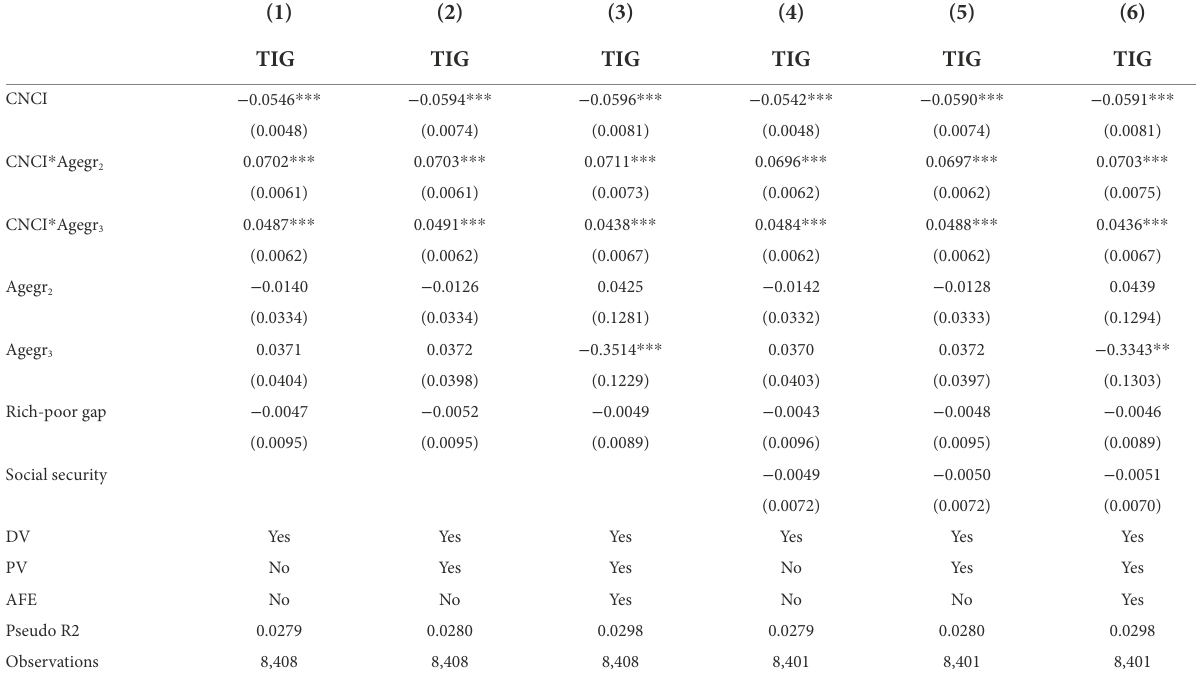
TABLE 10 Robustness test: Add control